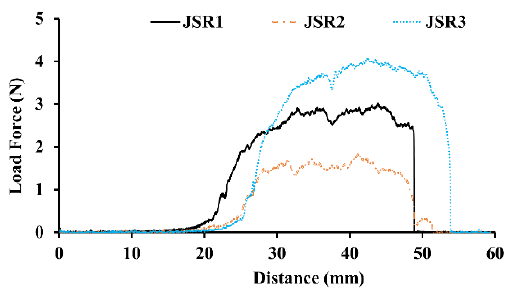
Figure 6. Peer test results of anodes made of different SBR binder (JSR1, JSR2 and JSR3).